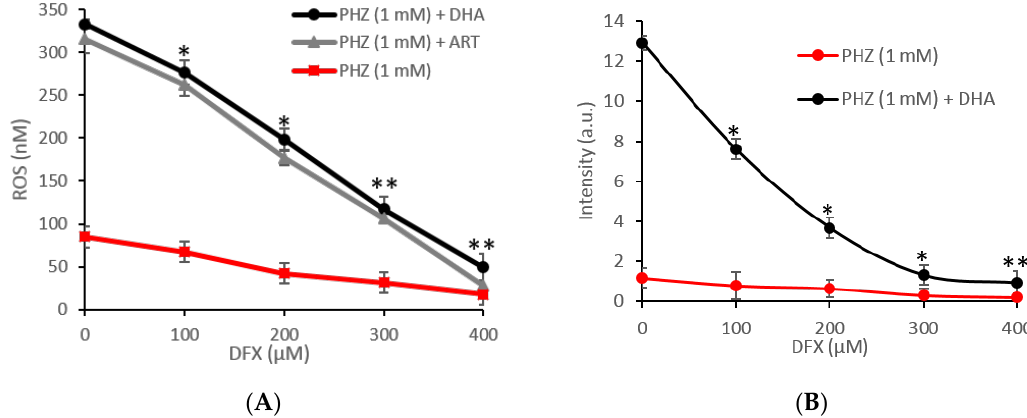
Figure 5. Effect of desferrioxamine (DFX) on the production of ROS measured by ( A ) LC-MS and ( B ) electron paramagnetic resonance (EPR) for RBC treated with phenylhydrazine (PHZ) (1 mM) and DHA (200 µM) or ART (200 µM). Data are the average ± SD of 5 independent experiments. Significant differences to untreated RBCs at * p < 0.05; ** p < 0.001.